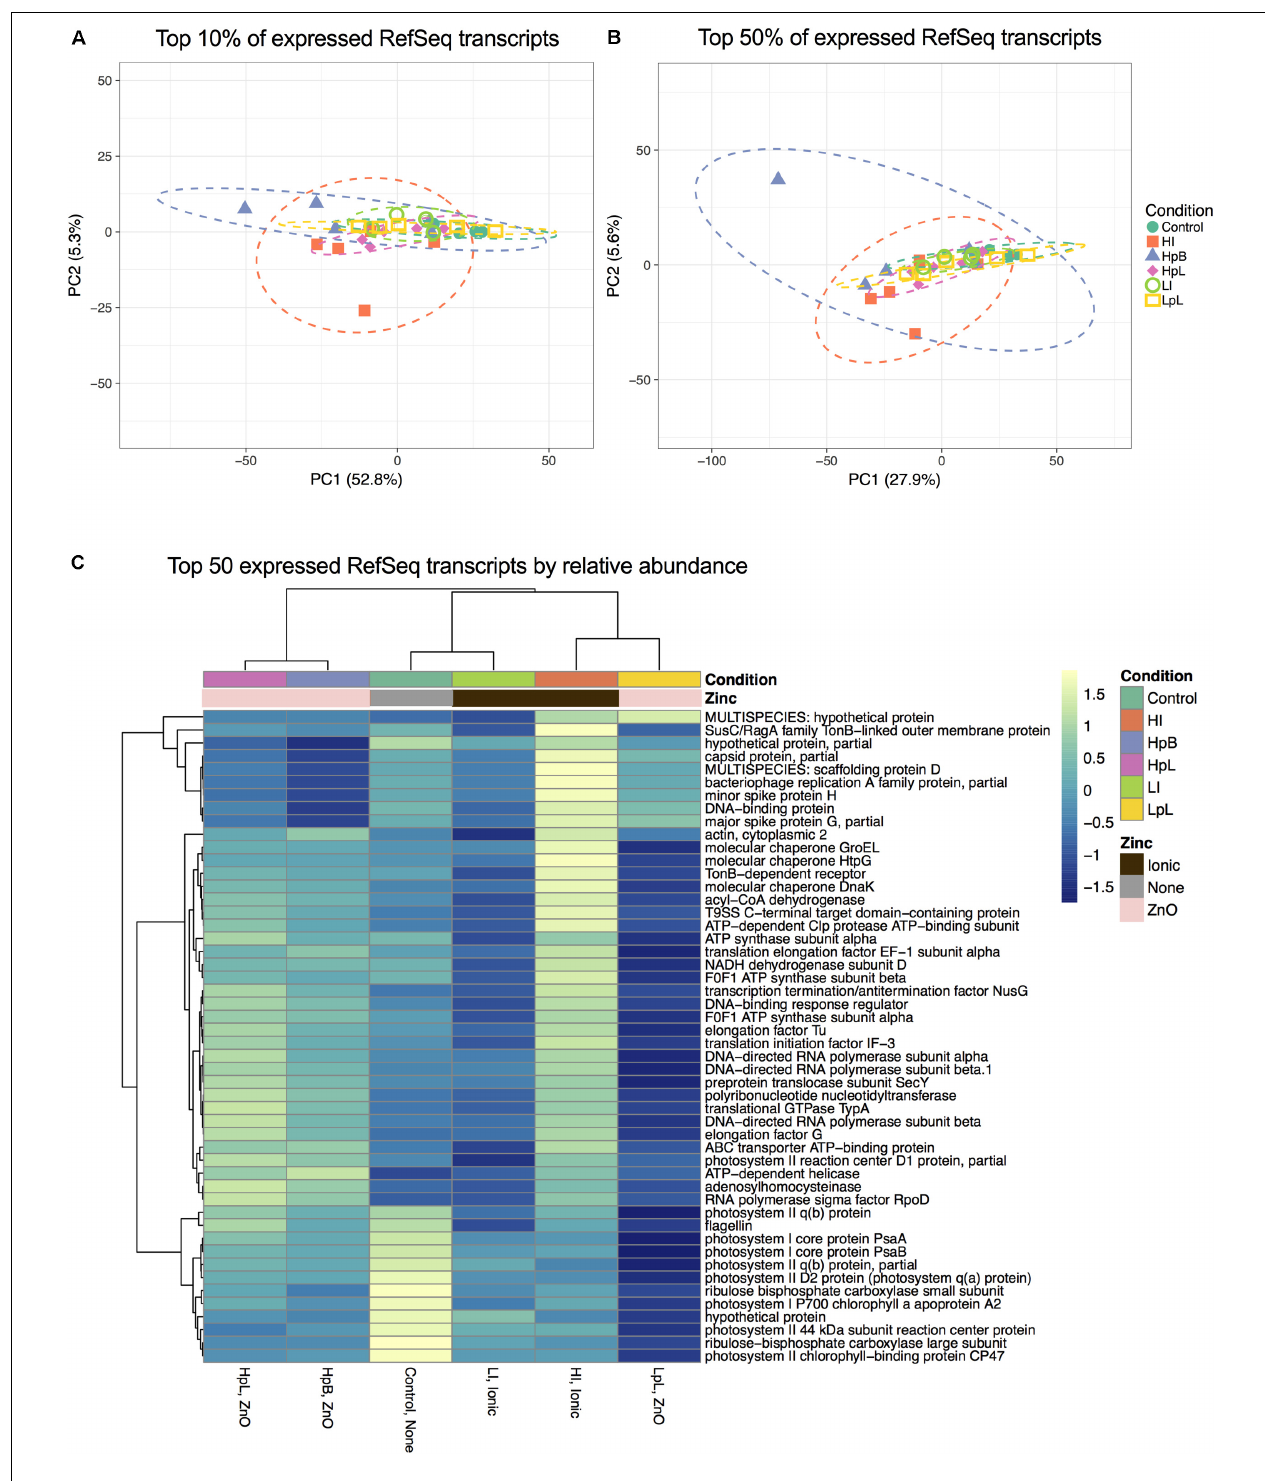
FIGURE 4 | PCA analysis of RefSeq-annotated genes for ( A ) top 10% expressed genes ( B ) top 50% expressed genes across all samples. Transcripts were included for analysis if they were detected in at least three replicates; N = 2,548 genes for (A) and N = 8,838 genes for (B) . Prediction ellipses are 0.95 probability. (C) Heatmap of top 50 abundant individual transcripts. Read abundance is normalized for individual samples according to total sample read number, then averaged for each treatment ( n = 5). Rows are centered with unit variance scaling applied. Both rows and columns are clustered using correlation distance and average linkage. Columns with similar annotations are collapsed by taking the mean inside each group, and the tightest cluster presented first.